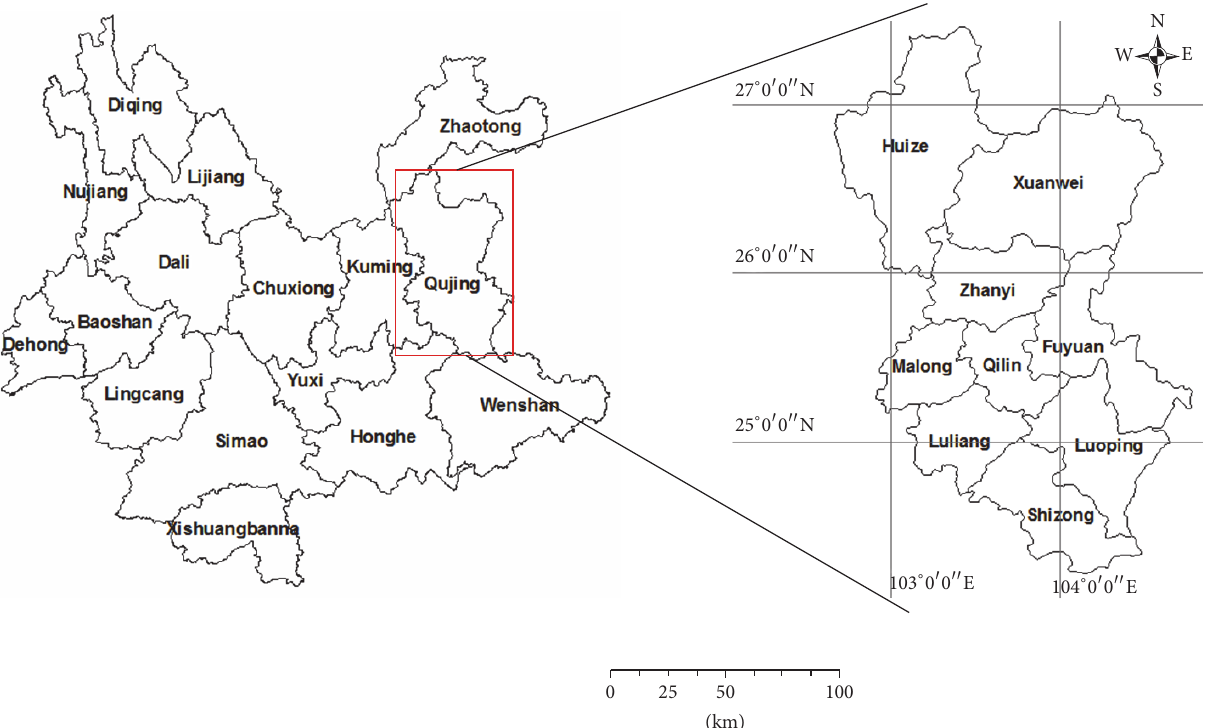
Figure 1: Geographic location of Qujing in Yunnan